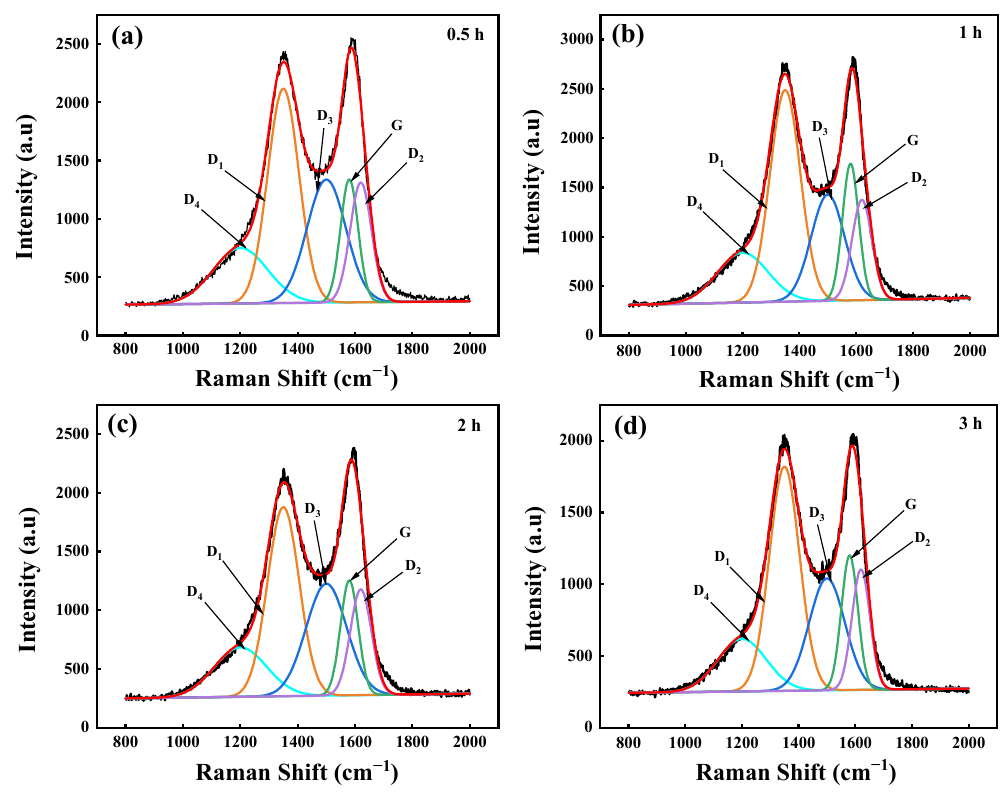
Figure 4. Fitting diagram of Raman peaks of coke and CO 2 at different melting-loss times. ( a ) 0.5 h; ( b ) 1 h; ( c ) 2 h; ( d ) 3 h. Table 2. Area ratios of fitted peaks for coke and CO 2 at different reaction times (%).